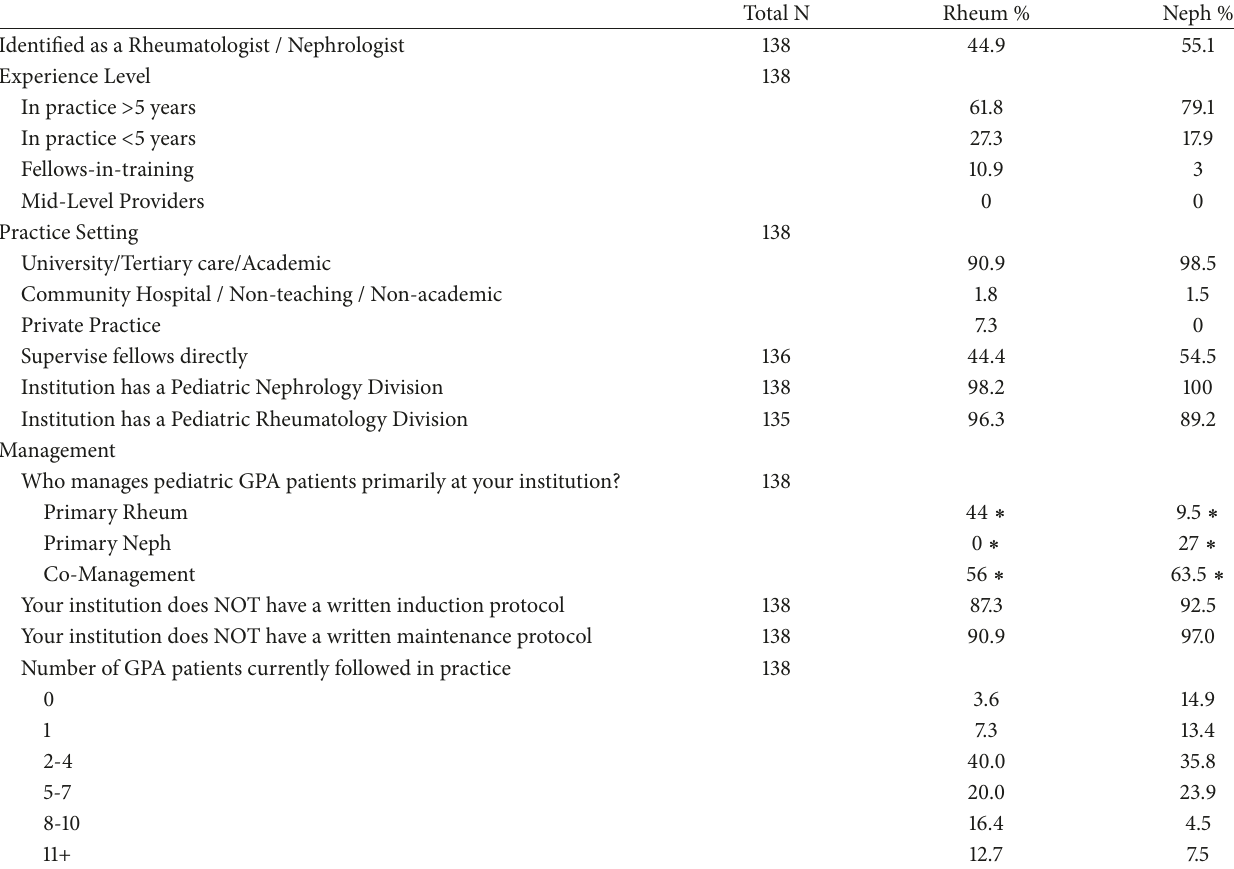
Table 1: General characteristics of survey